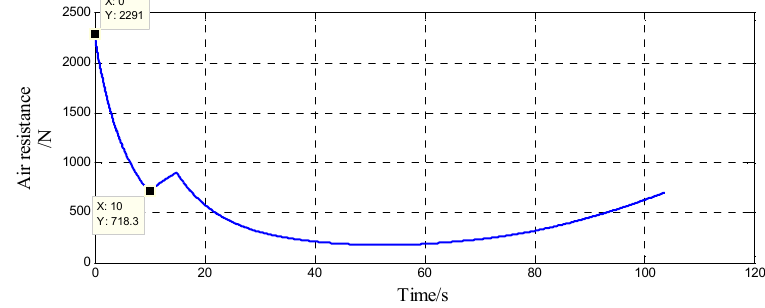
Figure 8. The air resistance of the projectile in out ‐ bore flight.